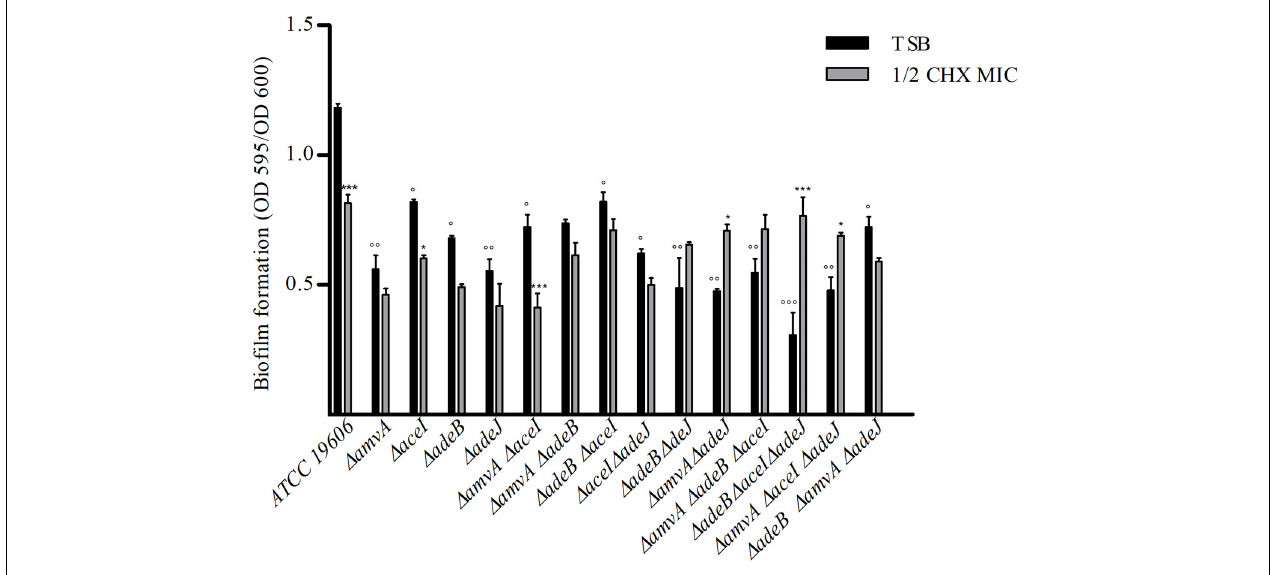
FIGURE 3 | Biofilm formation of A. baumannii ATCC 19606 parental strain and single, double and triple deletion mutants in the absence (TSB) or the presence of 1 / 2 CHX MIC. P -values were calculated using ANOVA ( ◦ p < 0.05, ◦◦ p < 0.01, or ◦◦◦ p < 0.001 vs. A. baumannii ATCC 19606 parental strain; * p < 0.05 or *** p < 0.001 vs. 1 / 2 CHX